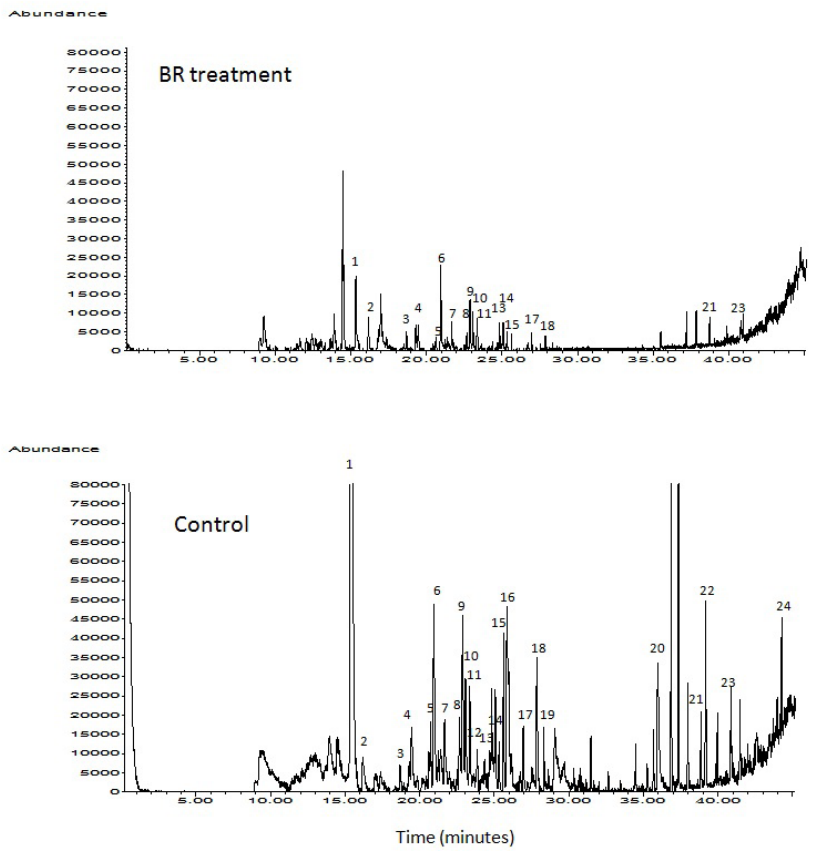
Figure 2: Comparison of chromatogram between BR treatment and control, numbers are corresponding with tentatively identified compounds in Table